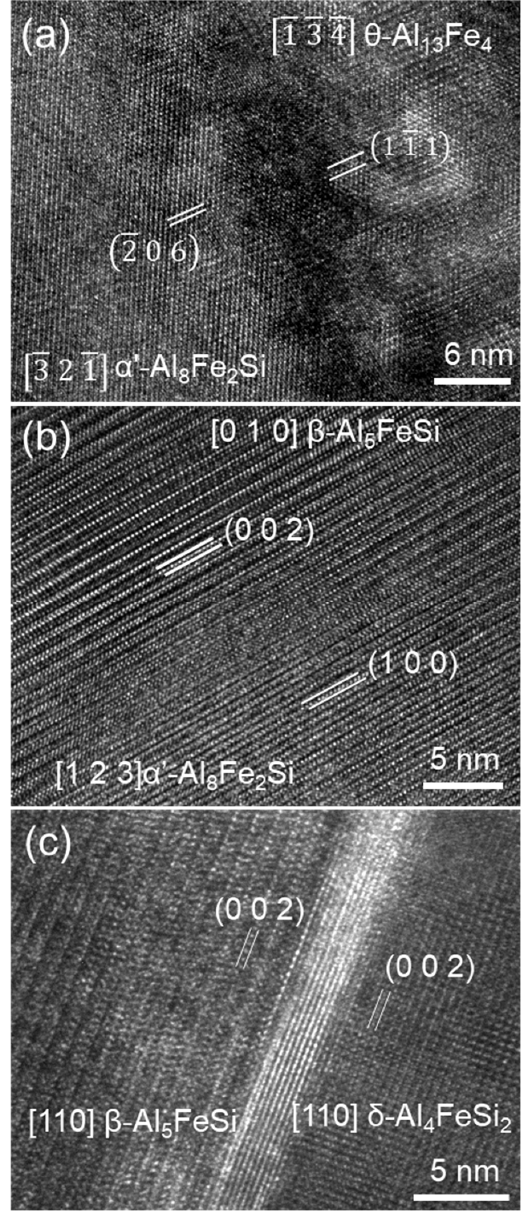
Figure 13. High ‐ resolution TEM (HRTEM) images showing the interfaces between different types Figure 13. High-resolution TEM (HRTEM) images showing the interfaces between different types of FIMCs in Al ‐ 20Si ‐ 0.7Fe alloy solidified at 0.01 K/s. ( a ) the interface between α ’ ‐ Al 8 Fe 2 Si and of FIMCs in Al-20Si-0.7Fe alloy solidified at 0.01 K/s. ( a ) the interface between α ’-Al 8 Fe 2 Si and θ‐ Al 13 Fe 4 , with the incident electron beam being paralleled to [ 1 3 4 ] zone direction of θ‐ Al 13 Fe 4 θ -Al θ -Al13Fe4 13 Fe 4 , with the incident electron beam being paralleled to [134] zone direction of and [ 3 2 1 ] zone direction of α ’ ‐ Al 8 Fe 2 Si; ( b ) the β‐ Al 5 FeSi/ α ’ ‐ Al 8 Fe 2 Si interface with the incident and [3 2 1] zone direction of α (cid:48) -Al 8 Fe 2 Si; ( b ) the β -Al 5 FeSi/ α (cid:48) -Al 8 Fe 2 Si interface with the incident electron beam being parallel with [0 1 0] zone direction of β‐ Al 5 FeSi and [1 2 3] zone direction of α ’ ‐ Al 8 Fe 2 Si, ( c ) the β‐ Al 5 FeSi/ δ‐ Al 4 FeSi 2 interface viewed along the [110] zone direction of β‐ Al 5 FeSi electron beam being parallel with [0 1 0] zone direction of β -Al 5 FeSi and [1 2 3] zone direction of and δ‐ Al 4 FeSi 2 in Al ‐ 20Si ‐ 0.7Fe alloy after heat treatment at 530 °C for 0.5 h. [67]. α (cid:48) -Al β -Al δ -Al β -Al 8 Fe 2 Si, ( c ) the 5 FeSi/ 4 FeSi 2 interface viewed along the [110] zone direction of 5 FeSi and δ -Al 4 FeSi 2 in Al-20Si-0.7Fe alloy after heat treatment at 530 ◦ C for 0.5 h.